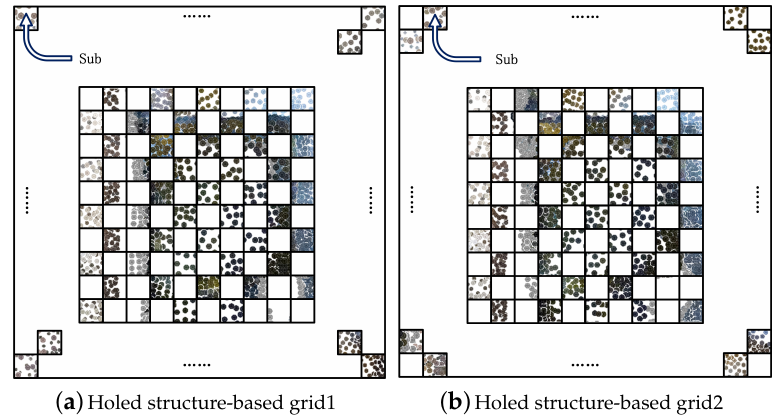
Figure 5. The complementary grids with holed structure.